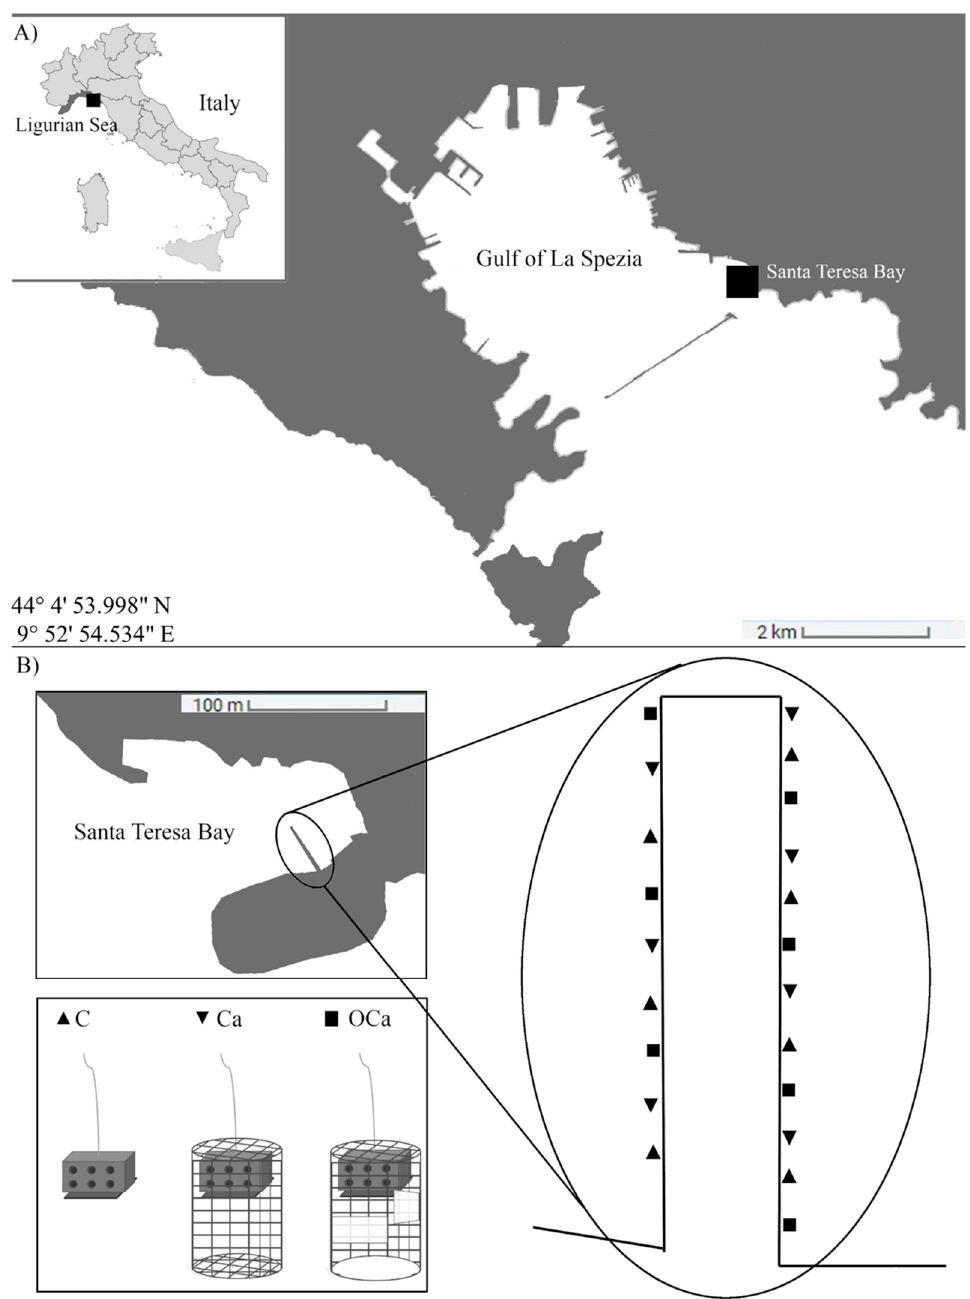
Figure 1. ( A ) General map of the location of the study area within the Gulf of La Spezia, Western Mediterranean Sea, Ligurian Sea, Italy. ( B ) Map of Santa Teresa Bay with the scheme of the different treatment levels of the experimental units deployed along the floating pontoon. The symbols indicate the treatment levels deployed with a scheme of the experimental units used: C, control; Ca, caged; and OCa, open-caged PVC